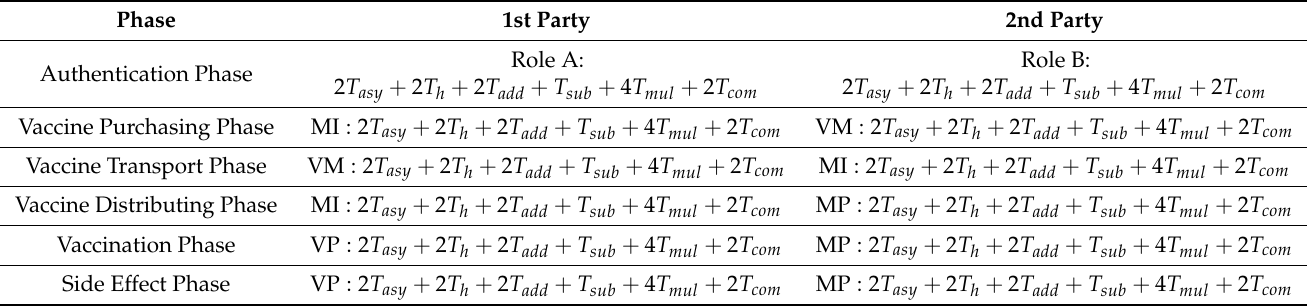
Table 2. The computation cost of each